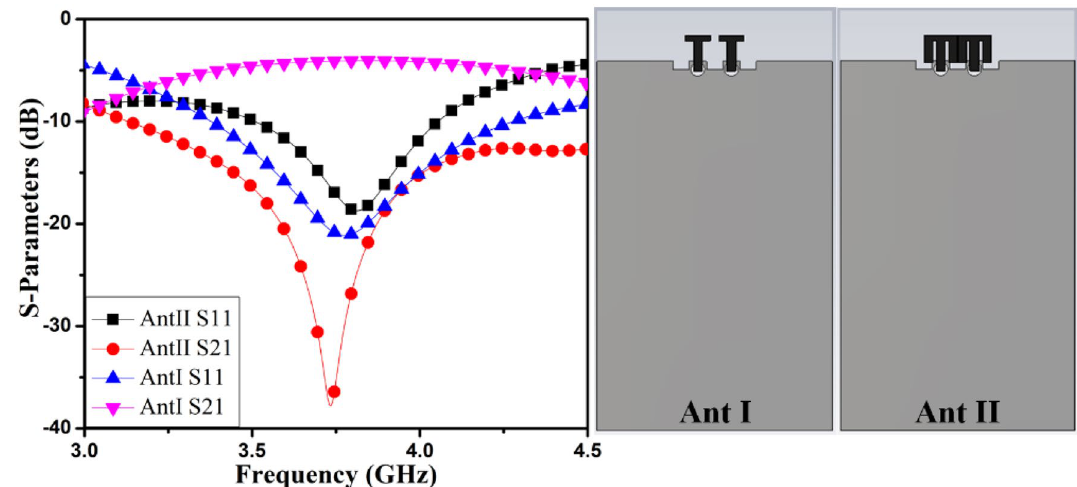
Figure 2. Evolution of MIMO antenna S-parameters.